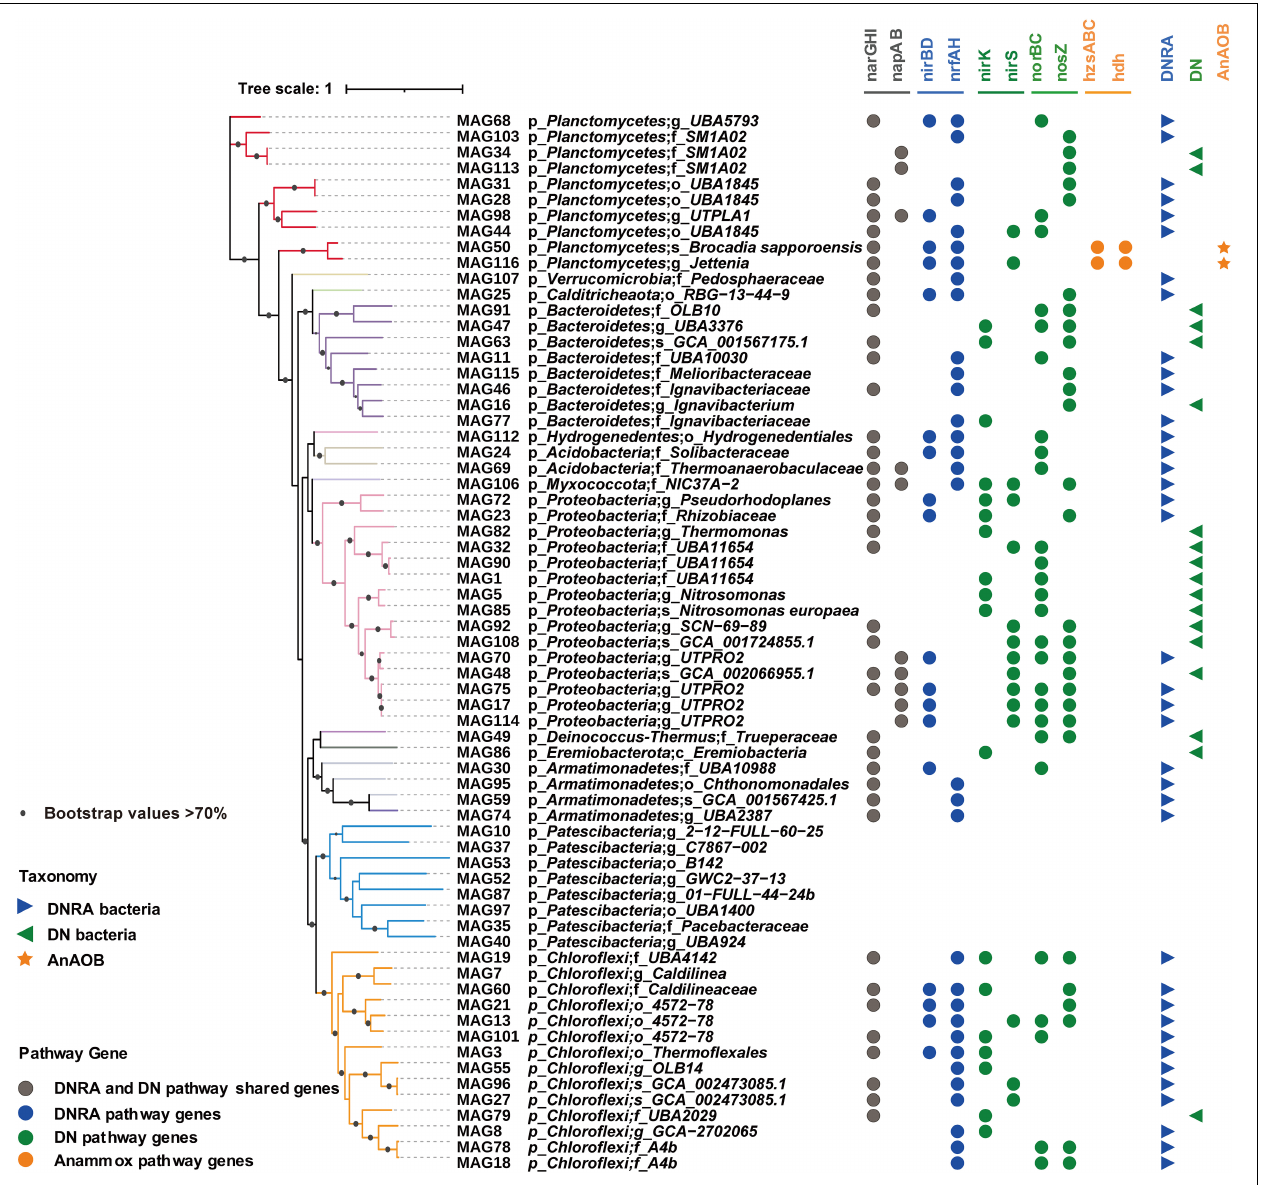
FIGURE 3 | Phylogenomic reconstruction of high-quality MAGs from anaerobic ammonium oxidation (anammox) bioreactor communities. A phylogenetic tree was generated by maximum likelihood (ML) (inferred with IQ-tree and LG + F + R6 model) with 1,000 bootstrap replications. Different colored tree branches indicated different phylum levels. Bootstrap values > 70% were highlighted with black circles. Genes in various metabolic pathways were marked with different colored circles by iTOL version 4.4.2. Consequently, pathway of high-quality MAGs was summarized as follows: AnAOB (orange stars)—MAGs found with anammox genes ( hzsABC / hdh ), dissimilatory nitrate reduction (DNRA) bacteria (blue triangles pointing right)—MAGs found with DNRA genes ( nirBD / nrfAH ), and denitrifying only (DN) bacteria (green triangles pointing left)—MAGs only with DN genes ( nirS/nirK/norBC / nosZ